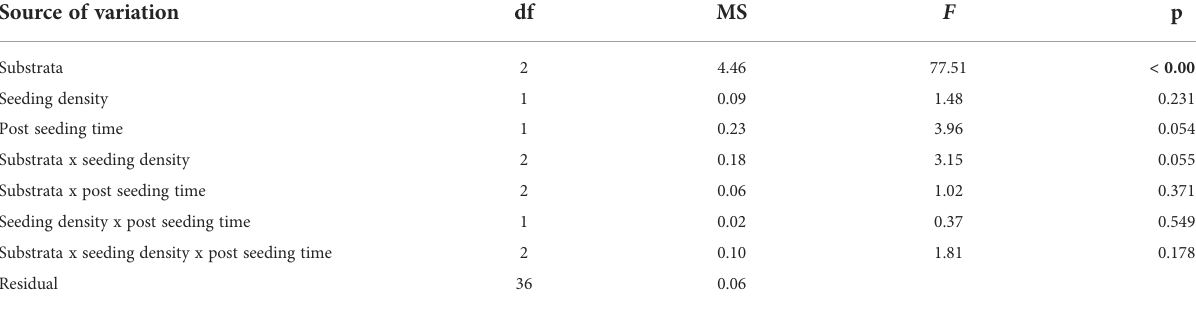
TABLE 2 ANOVA main test results testing for the effect of substrata ( fi xed factor), seeding density ( fi xed factor), post-seeding time ( fi xed factor) and their interactions on reproductive success of detached Ecklonia radiata gametophytes from green gravel on Day 56. Source of variation